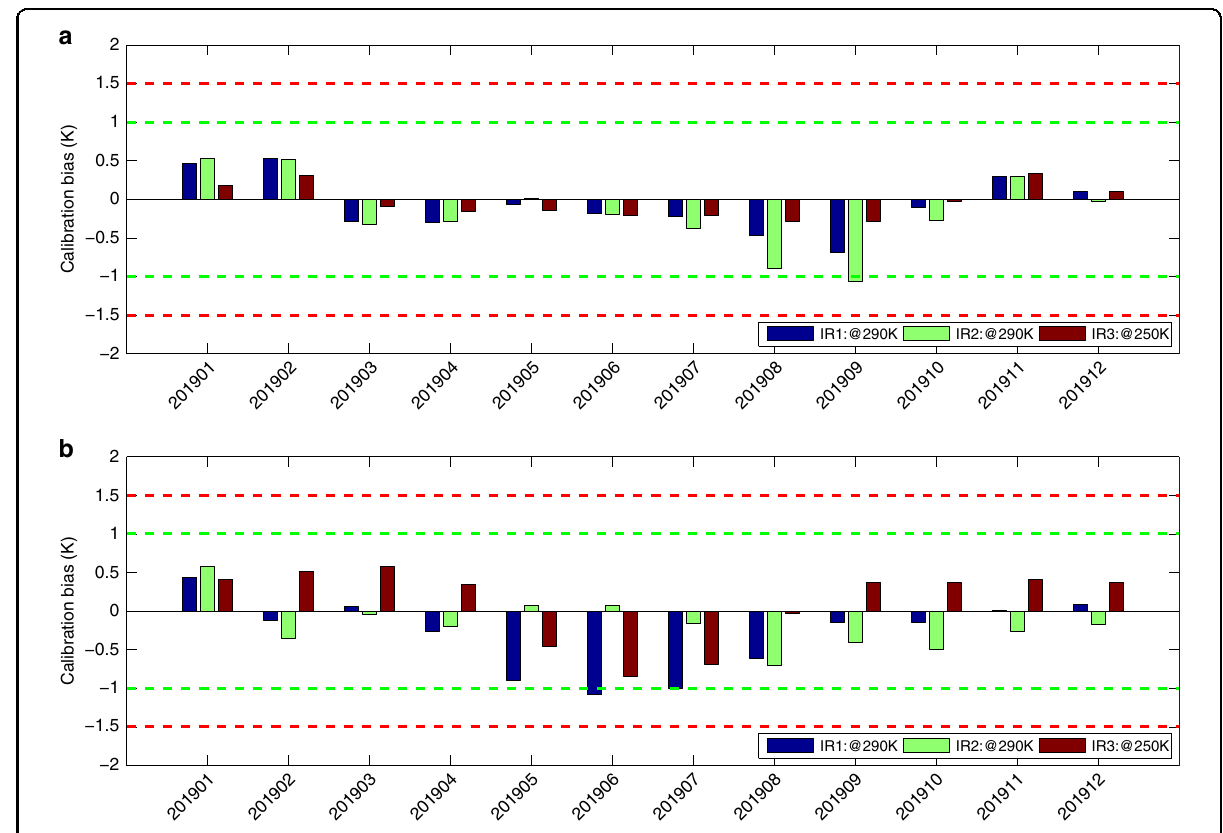
Fig. 3 Monthly calibration biases of FY-2F and FY-2G VISSR with SIRC method for the period of 2019. a Reprocessed FY-2F results with SIRC method; b Operational FY-2G results with SIRC method. These calibration biases are intercalibrated with some reference hyperspectral sensors (i.e., IASI) under the framework of